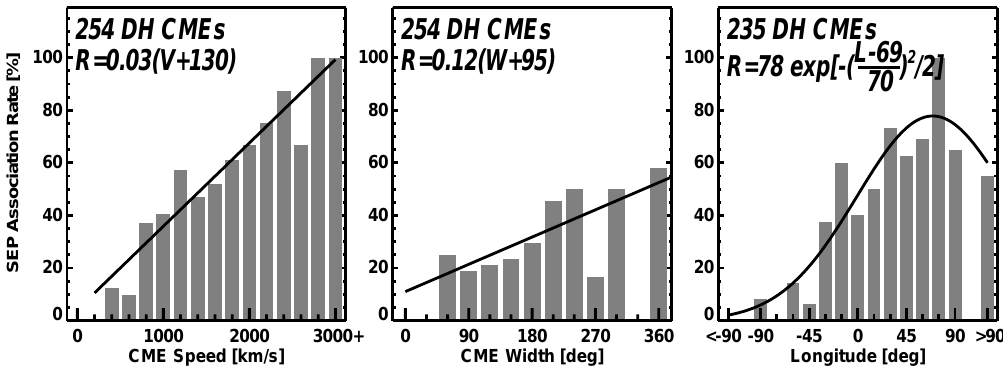
Fig. 10. SEP association rate (R) as a function of CME speed (V km/s), width (W degrees) and source longitude (L degrees) for CMEs associated with DH type II bursts. The curves fitted to the rate are shown on the plots. Note that out of the 334 RL (DH) CMEs, only the 254 CMEs with SEP intensity ≥ 1pfu are included. The number of CMEs in the longitude distribution is smaller because source location is not available for some